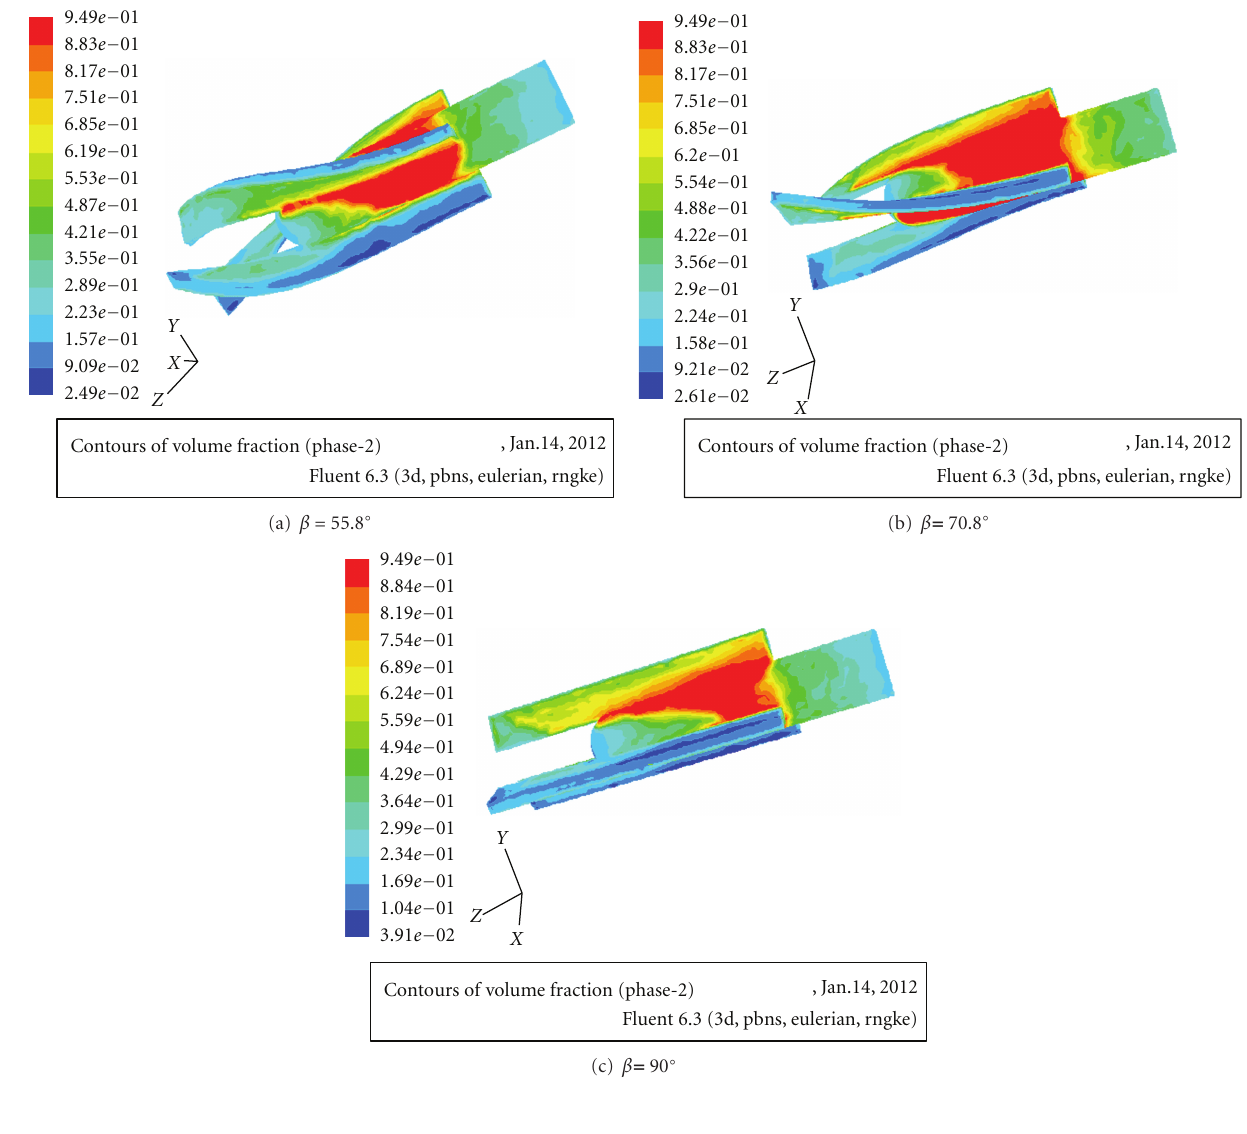
Figure 7: Gas distribution on the blade surfaces with di ff erent blade laying